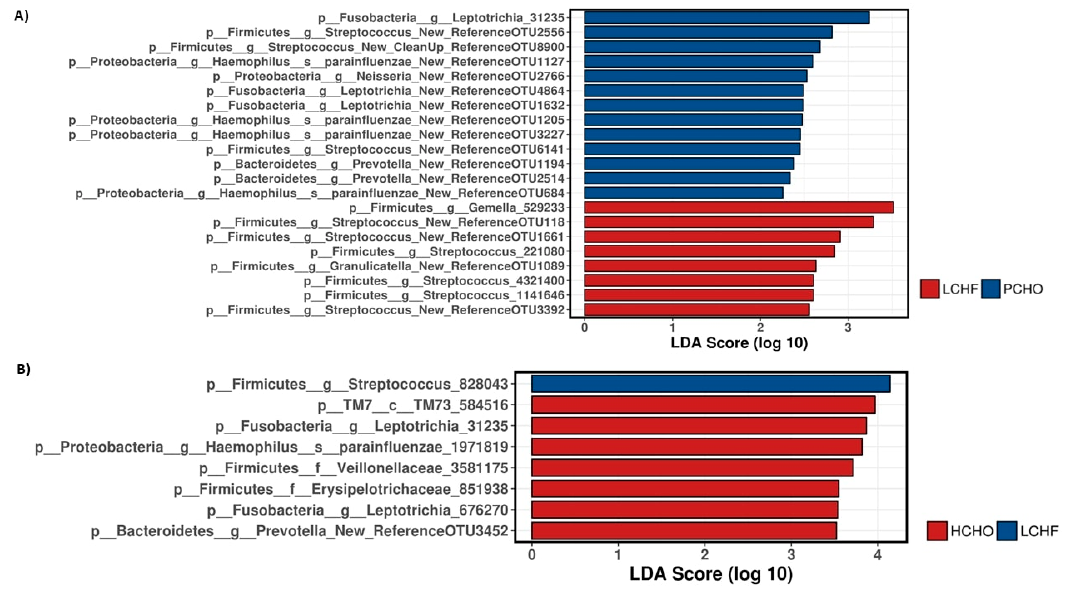
Figure 6. Linear Discriminant Analysis (LDA) Effect Size (LefSe) analysis at Operational Taxonomic Unit (OTU) level to compare the oral microbiome profiles of athletes post training diet interventions between Periodised Carbohydrate/Low Carbohydrate High Fat diet (PCHO/LCHF) ( A ) and High carbohydrate-Low Carbohydrate high-fat diet (HCHO/LCHF) ( B ), respectively.